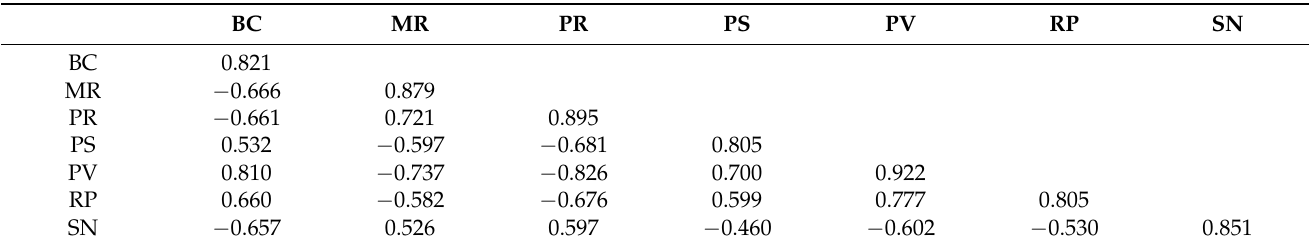
Table 3. Results of discrimination validity test of the scale.